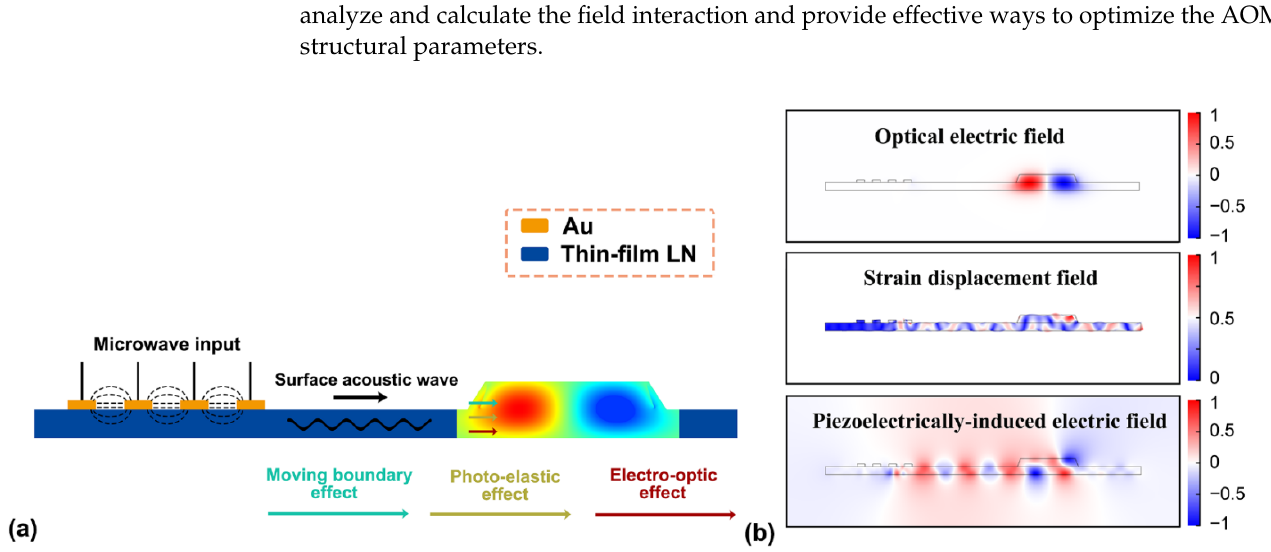
Figure 2. ( a ) Schematic of the working process of the proposed AOM. The microwave input and generated SAW are marked in the cross-sectional structure ( x - z direction) of the AOM. Three multi- physical effects affecting the refractive index change of the optical waveguide are also plotted. ( b ) Mode distributions of the optical electric field, strain displacement field, and the piezoelectrically induced electric field for the same cross-sectional structure of AOM. The working wavelength is 1550 nm and the frequency of the acoustic mode is 4.08 GHz.